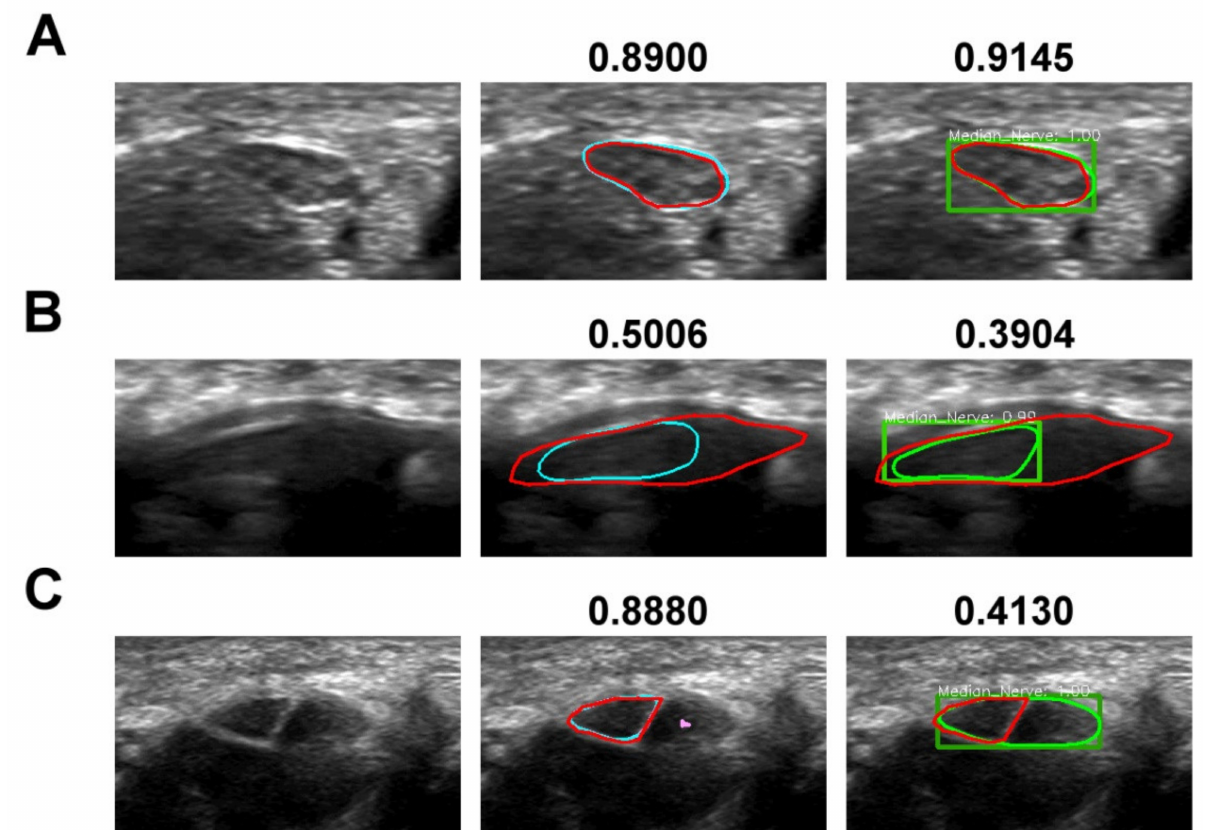
Figure 1. MN US images with various IoU scores. The first, second, and third column refers to the input image, and the image superimposed with MN region predicted by DeepLabv3+ and Mask R-CNN, respectively. The red, light blue, and light green line represents the ground truth, and the segmentation of MN predicted by DeepLabv3+ and Mask R-CNN, respectively. The dark green rectangle denoted the bounding box of the highest confidence score for MN in Mask R-CNN. The numbers above individual panel denoted the corresponding IoU scores. ( A ) MN image with high IoU scores in both models; ( B ) MN with blurred appearance and low IoU scores in both models; ( C ) MN image with clear but ambiguous appearance. The MN predicted by DeepLabv3+ with the largest area successfully recapitulated the true MN region, and that of a smaller size (labelled with pink color in the hypoechoic structure) was excluded from the final output. However, the MN segmented by Mask R-CNN mistook the hypoechoic structure for part of the